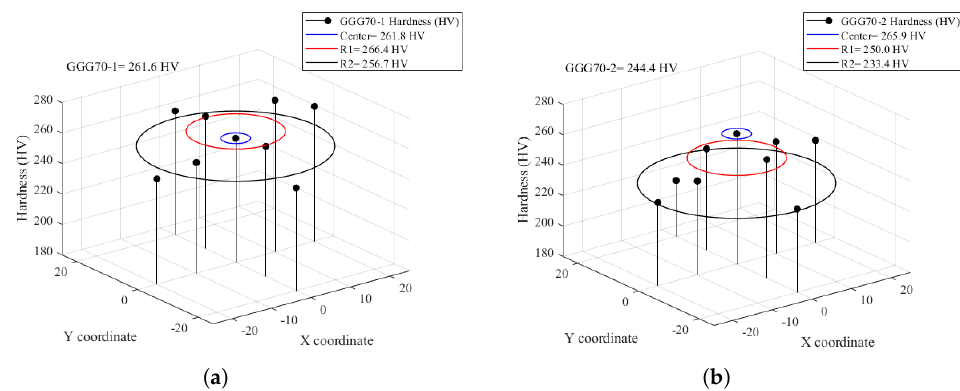
Figure 17. Hardness test round bar sample. ( a ) GGG70-1. ( b ) GGG70-2.